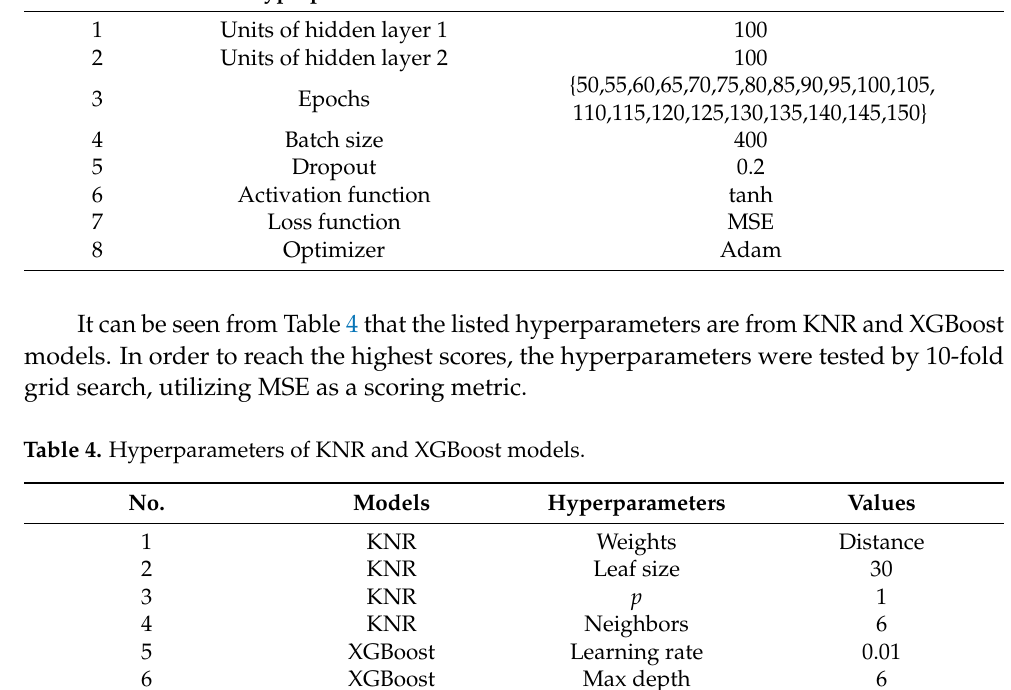
Table 3. Hyperparameters of deep neural network models (ISTL-LSTM, STL-LSTM, LSTM, GRU). No.